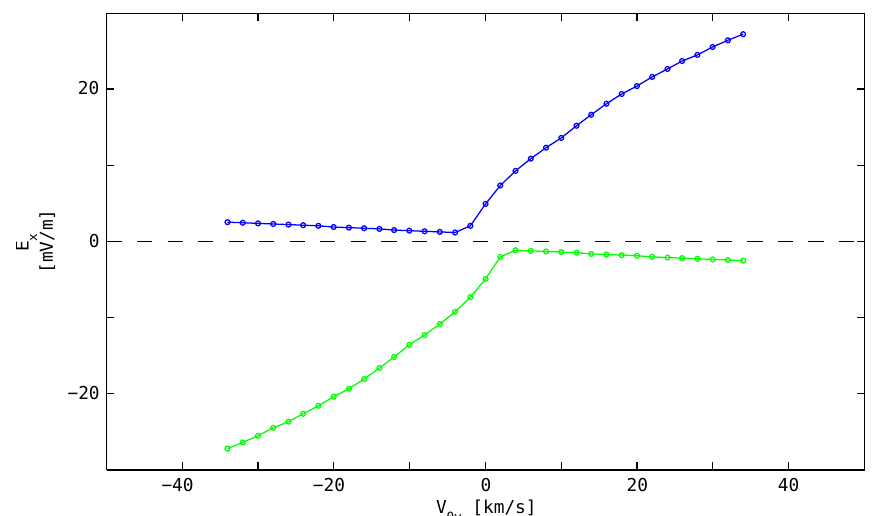
Fig. 10. Minimum (green) and maximum (blue) electric field strength in a 2000km-wide e − -H + slab for various values of V 0 y in a configuration where φ( ±∞ ) = 0V. No equilibrium is found for | V 0 y | > 35kms − 1 .